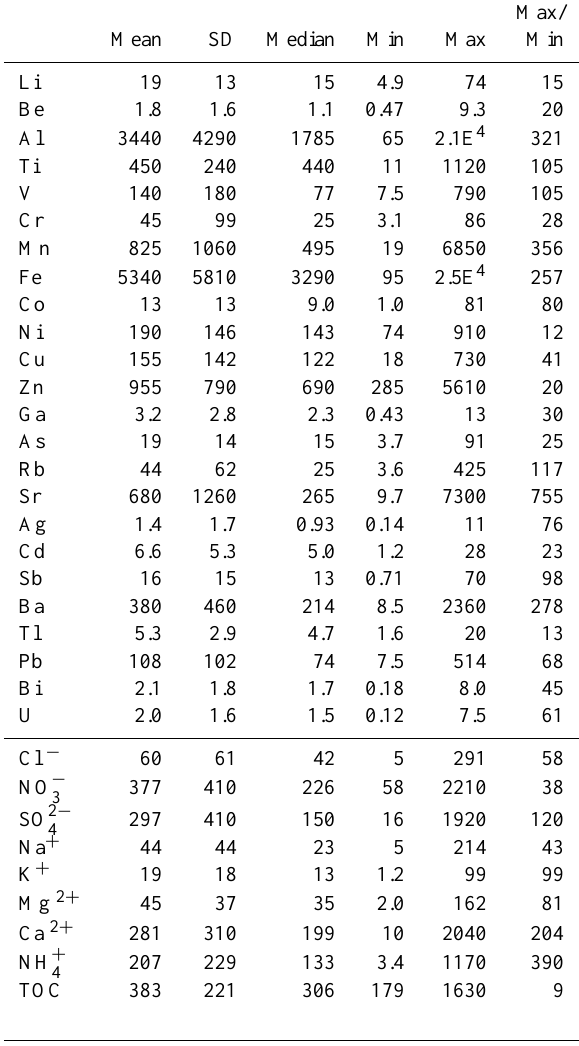
Table 1. Main statistics of the species determined in the snow pit on the glacier Alto dell’Ortles. The concentrations of the trace elements are expressed in pgg − 1 while the ionic compounds in ngg − 1